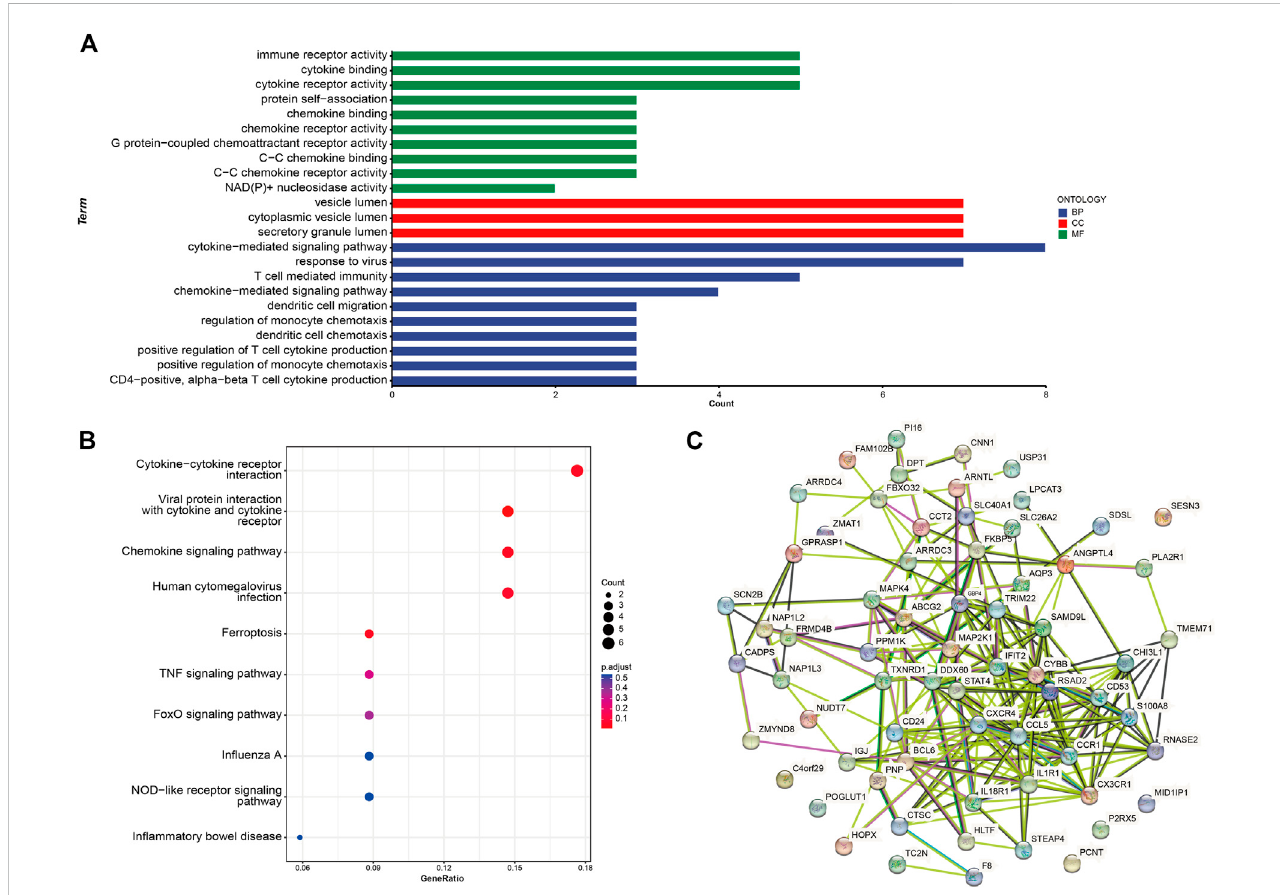
FIGURE 3 Enrichment analyses for common DEGs. (A) GO enrichment analysis. (B) KEGG enrichment analysis. (C) PPI network; the nodes represent proteins, and theedgesrepresentinteractions.GO,GeneOntology;BP,biologicalprocesses;CC,cellularcomponents;MF,molecularfunction;KEGG,KyotoEncyclopedia of Genes and Genomes; PPI, protein − protein